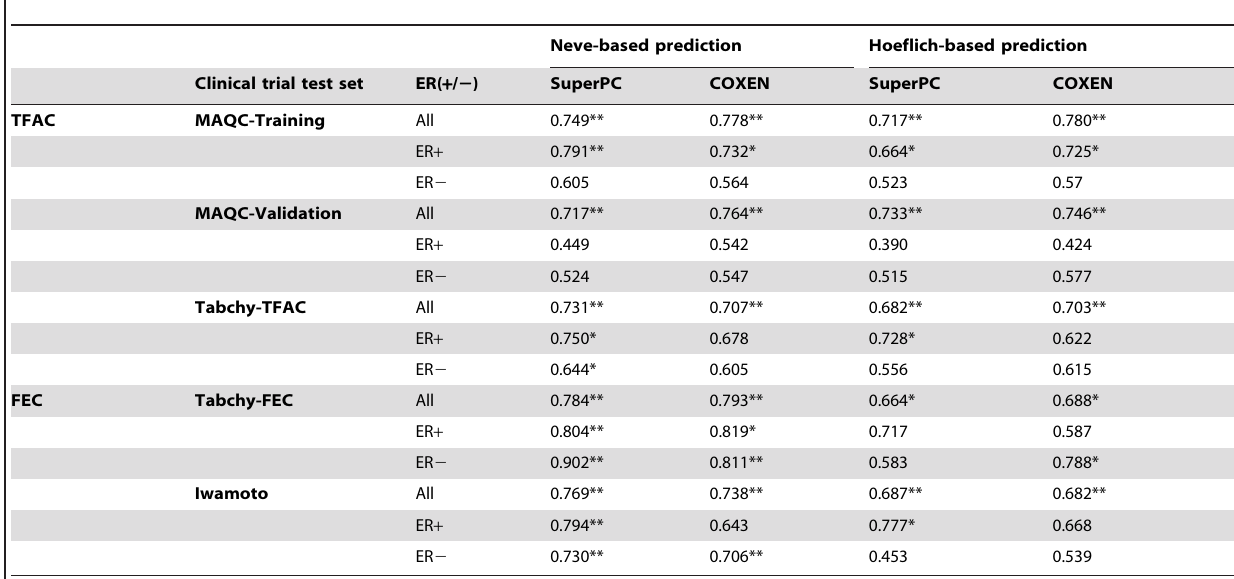
Table 3. Prediction results for the superPC and COXEN methods in all breast cancer cell lines evaluated by AUC